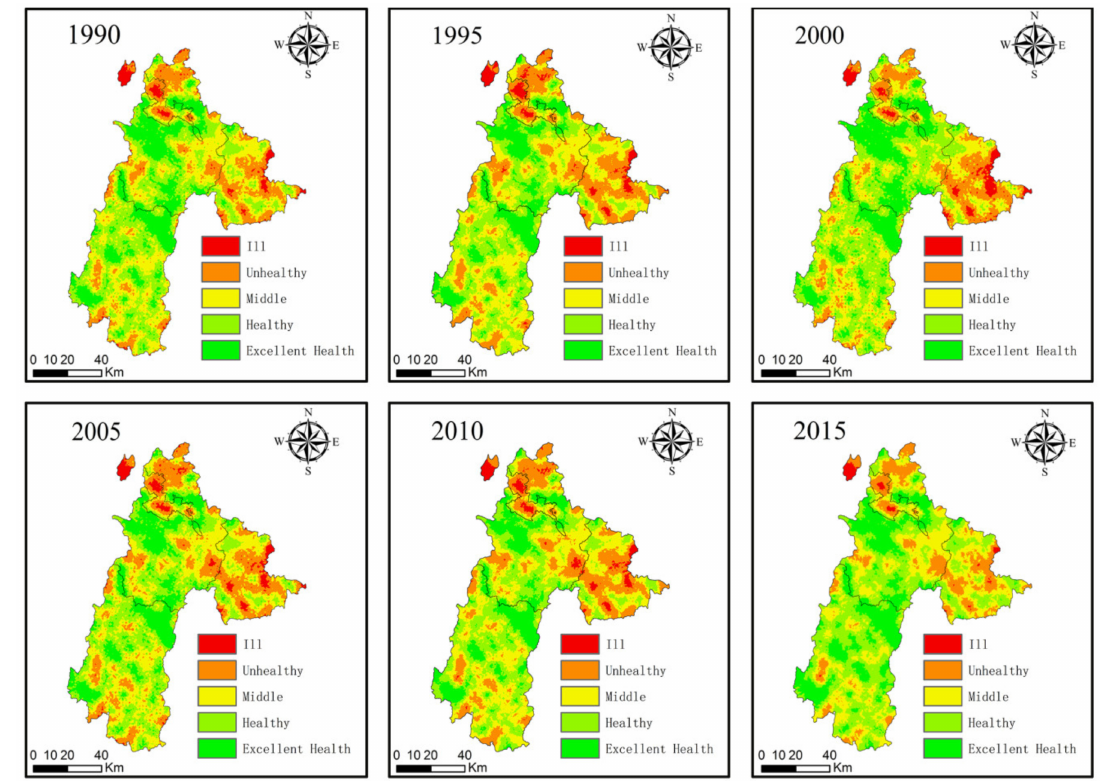
Figure 4. Spatio-temporal distribution of ecosystem health in